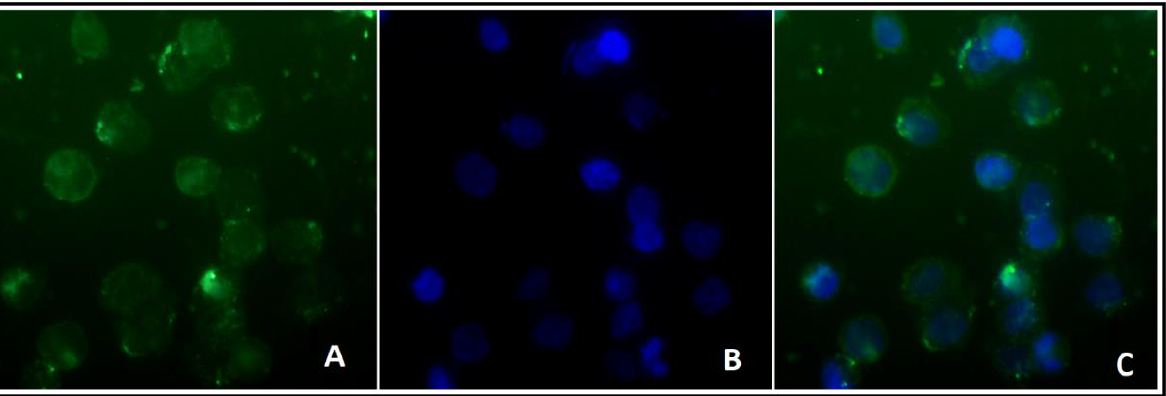
Figure 11. Cellular internalisation of SM-MIL in IMR-32 cells. ( A ) FITC-labelled SM-MIL nanoparticles. ( B ) DAPI-stained nuclei. ( C ) Overlay image of ( A , B ).